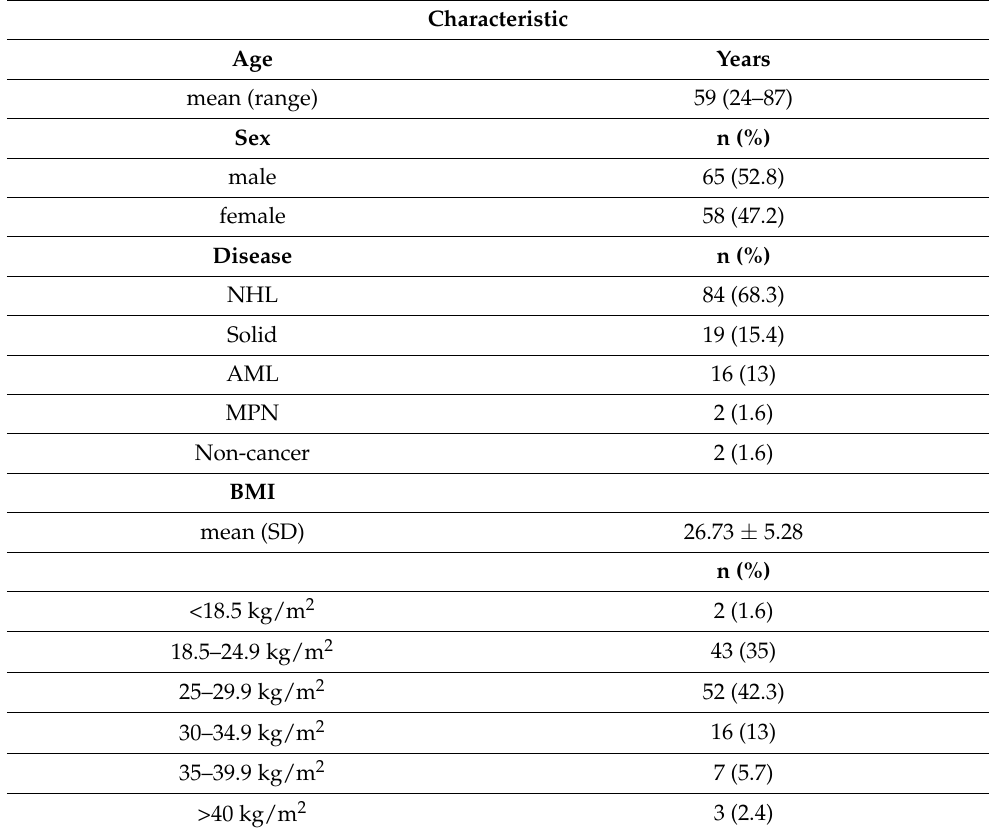
Table 1. The characteristics of the included study